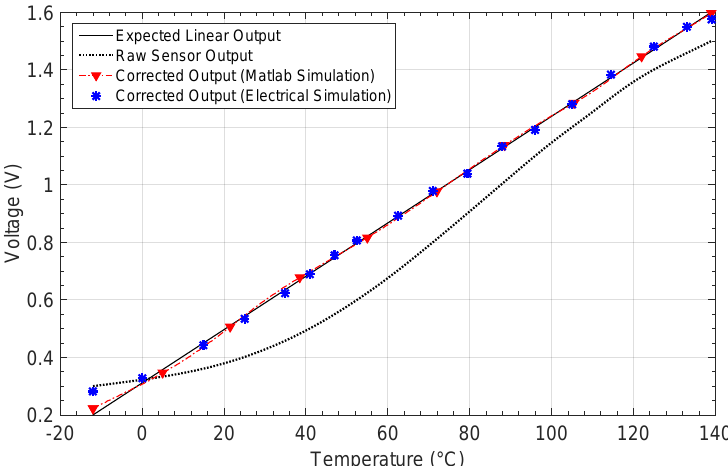
Figure 17. Non-linear output characteristic NL1 compared with the output obtained after electrical